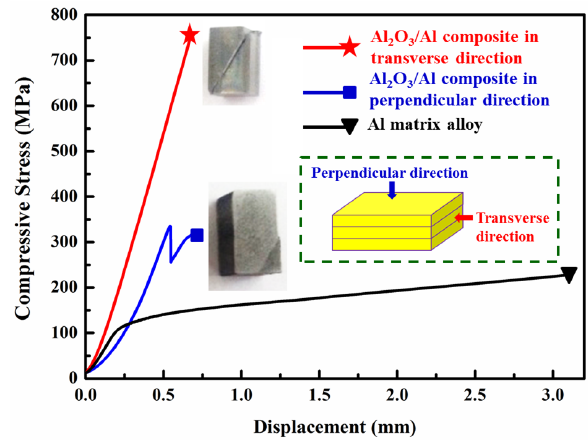
Figure 6: Representative compressive curves of the lamellar Al 2 O 3 p/Al composite in transvers and perpendicular directions and Al